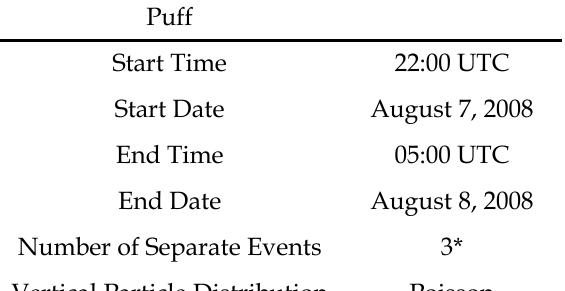
Table 1: Parameters chosen for Puff and the Volcanic Ash Retrieval [* as described by Waythomas et al. (2010); NCAR=National Center for Atmospheric